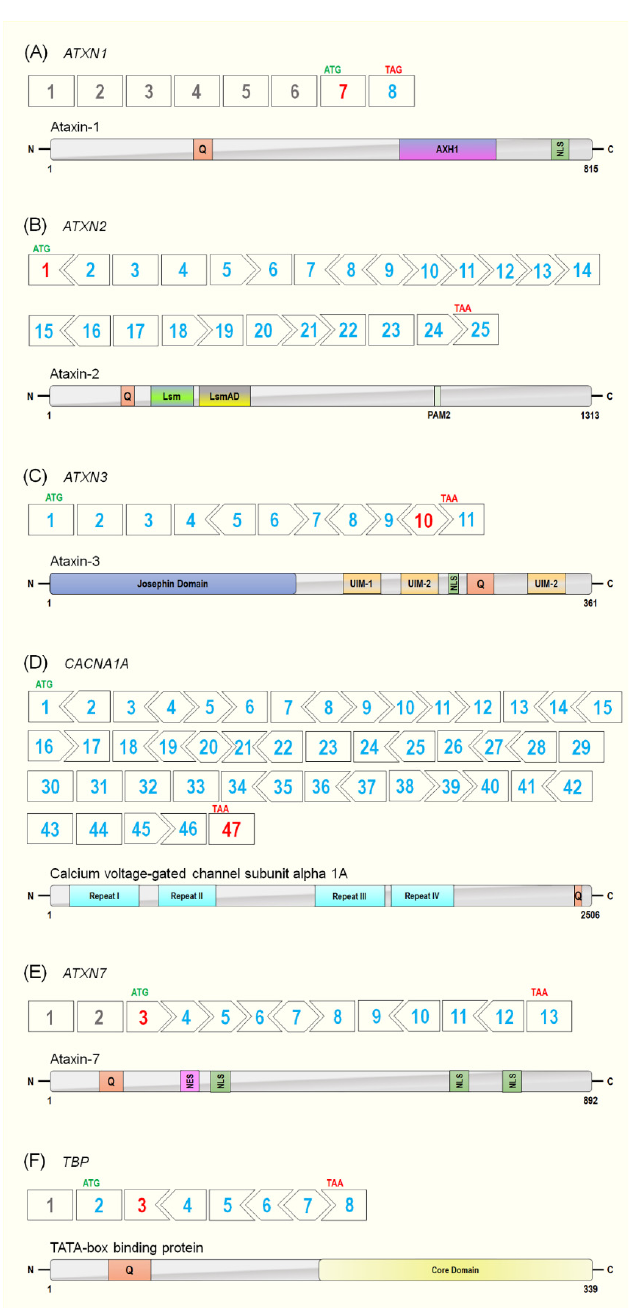
Figure 3. Schematic representation of the polyglutamine spinocerebellar ataxia causative gene reading frames and their respective protein organisations: ( A ) ATXN1 reading frame and the encoded Ataxin-1 protein organisation; ( B ) ATXN2 reading frame and the encoded Ataxin-2 protein organisation; ( C ) ATXN3 reading frame and the encoded Ataxin-3 protein organisation; ( D ) CACNA1A reading frame and the encoded Calcium voltage-gated channel subunit alpha 1A protein organisation; ( E ) ATXN7 reading frame and the encoded Ataxin-7 protein organisation; ( F ) TBP reading frame and the encoded TATA-box binding protein organisation. In-frame exons are represented as rectangles, whereas those bounded by partial codons are represented with chevron sides. Grey exons represent non-coding exons, while blue exons represent coding exons, and red exons represent the exon in which the polyQ repeat is located: AXH1 = AXH1 domain; Lsm = like-Sm domain; LsmAD = Lsm associated domain; NES = nuclear export signal; NLS = nuclear localisation signal; PAM2 = PABP- interacting motif 2; UIM = ubiquitin-interacting motif. Q = polyglutamine